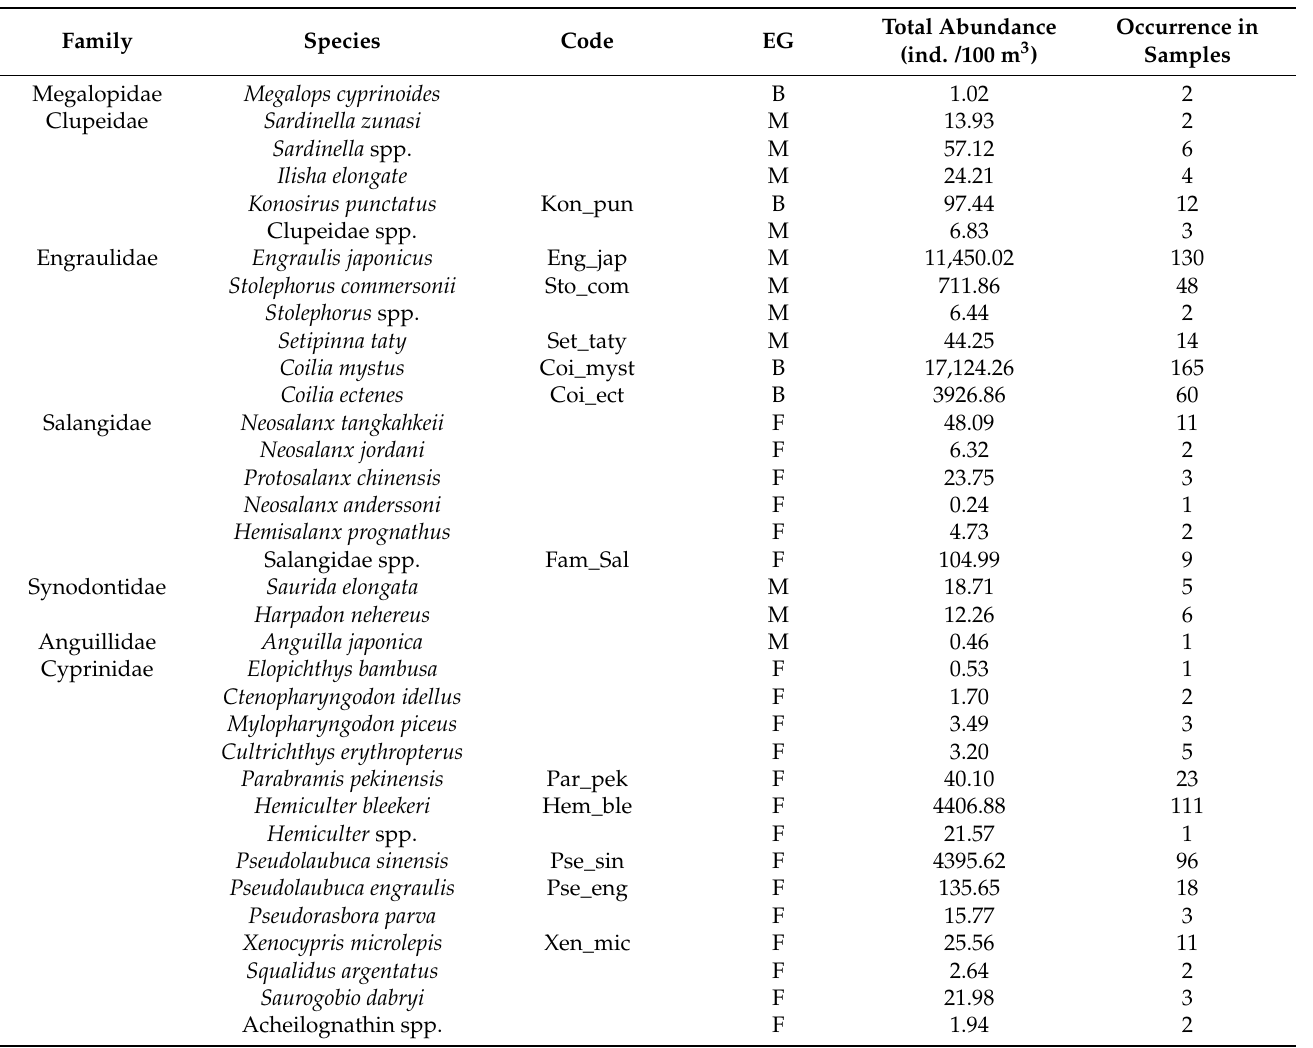
Table A1. Larval fish abundance and their occurrence in the Yangtze